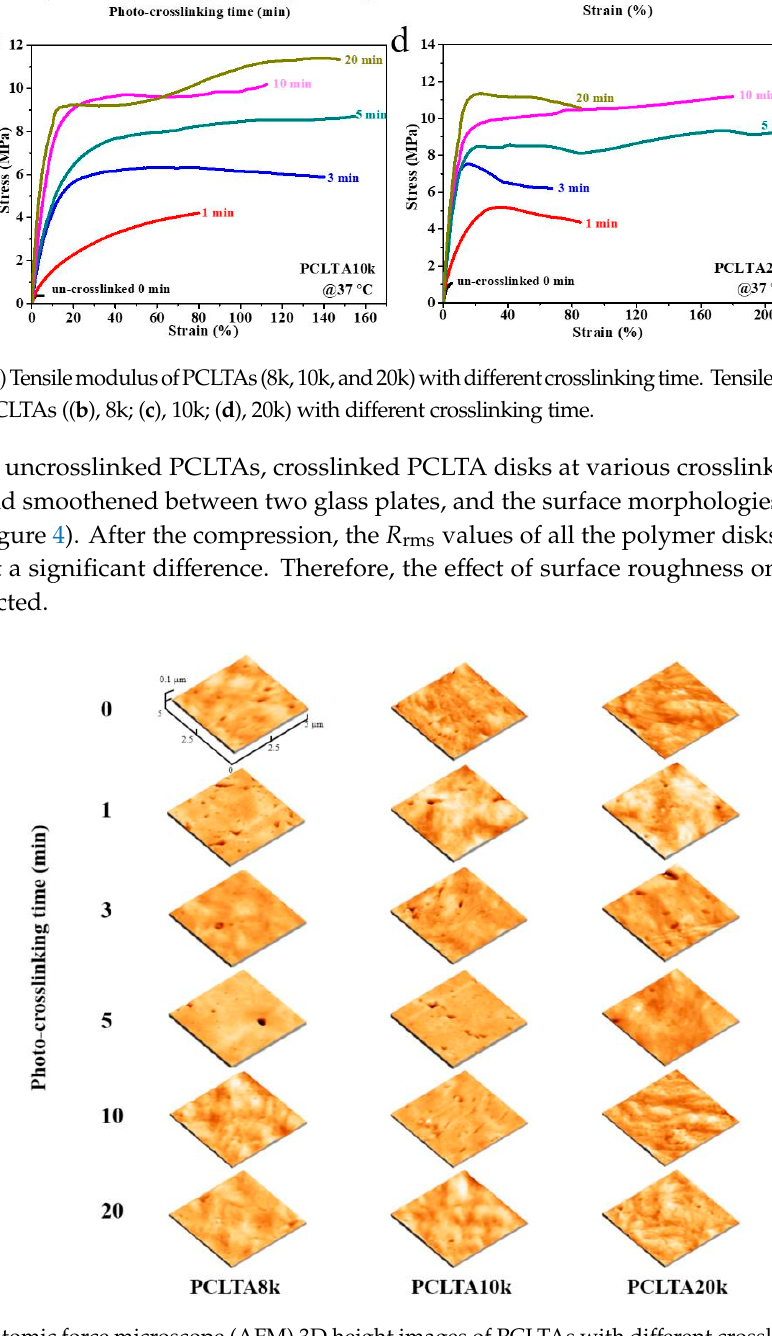
Figure 4. Atomic force microscope (AFM) 3D height images of PCLTAs with different crosslinking time.